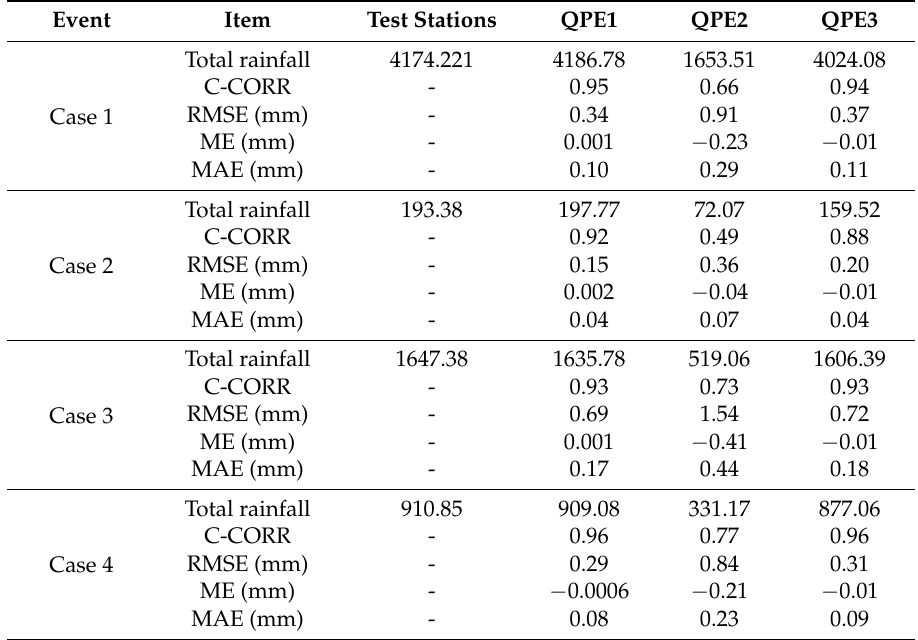
Table 2. Statistics of the comparison between the cross-validation estimates of each quantitative precipitation estimations and rain gauge